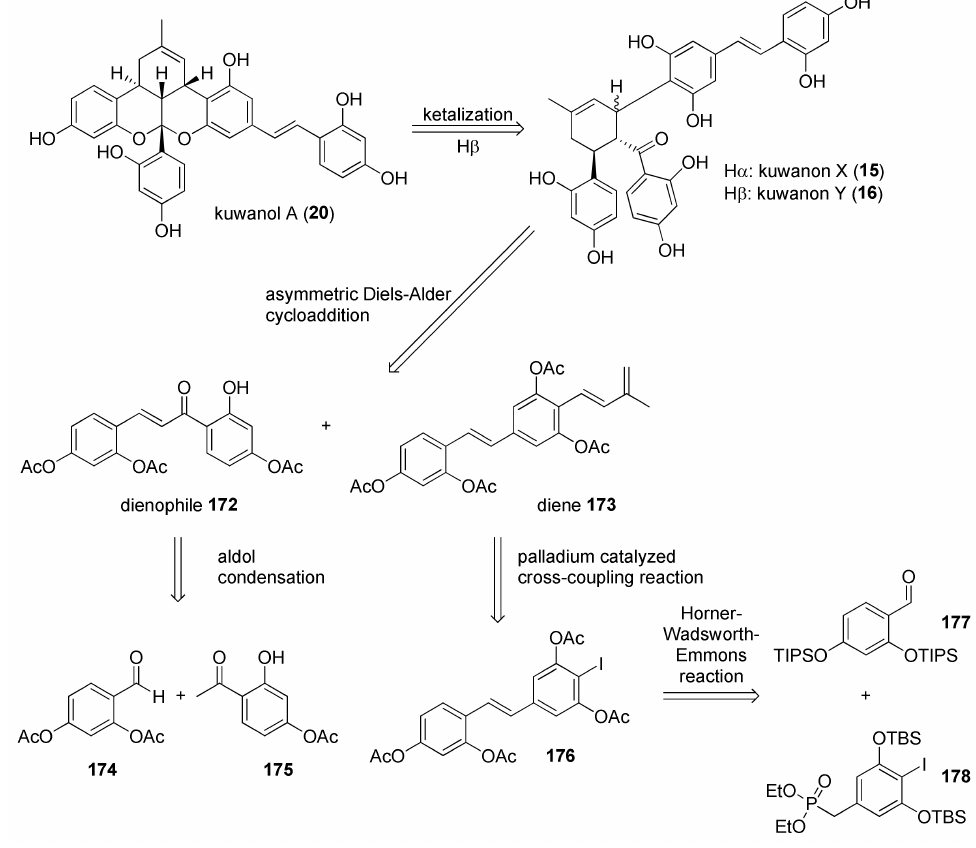
Figure 58. Retrosynthetic approach towards ( − )-kuwanon X ( 15 ), (+)-kuwanon Y ( 16 ), and (+)-kuwanol A ( 20